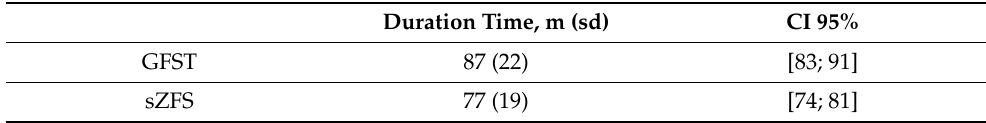
Table 7. Scales administration